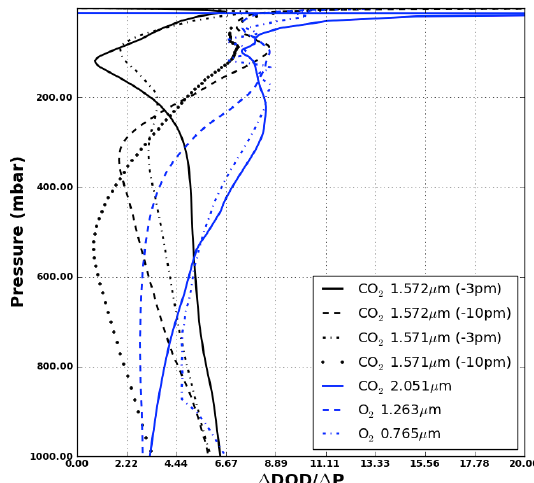
Figure 3. The variability in the differential optical depth weighting functions due to differences in NWP temperature and moisture as a function of vertical height. The values are the standard deviations of the difference between the average weighting function values and the ensemble members as a percentage of the mean weighting func- tion value.